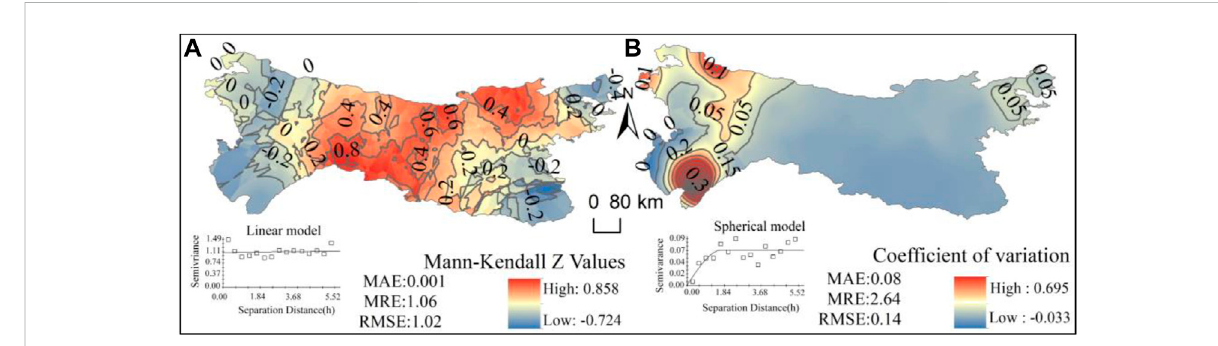
FIGURE 6 Spatial distribution of Mann-Kendall Z -value (A) and coef fi cient of variation (B) of rainfall erosivity in Qinba Mountains.